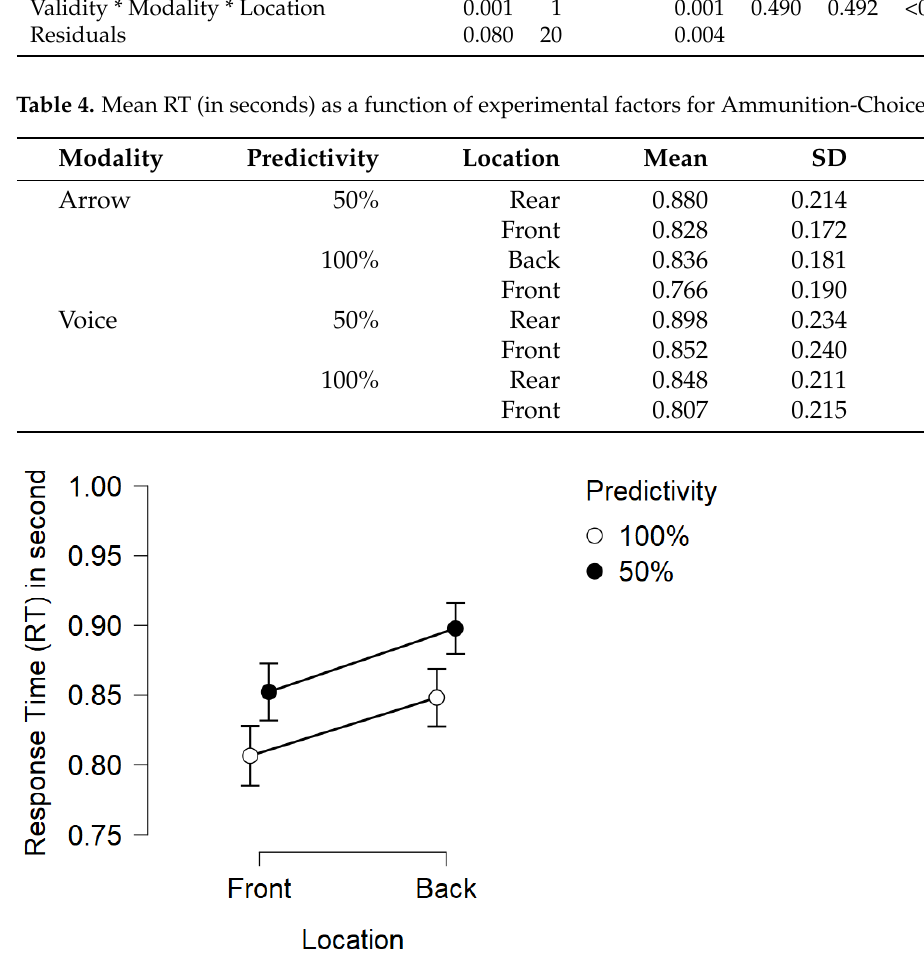
Figure 3. Mean RTs for Ammunition-Choice in response to auditory cues according to cue predictivity and cue-target location. Bars represent standard